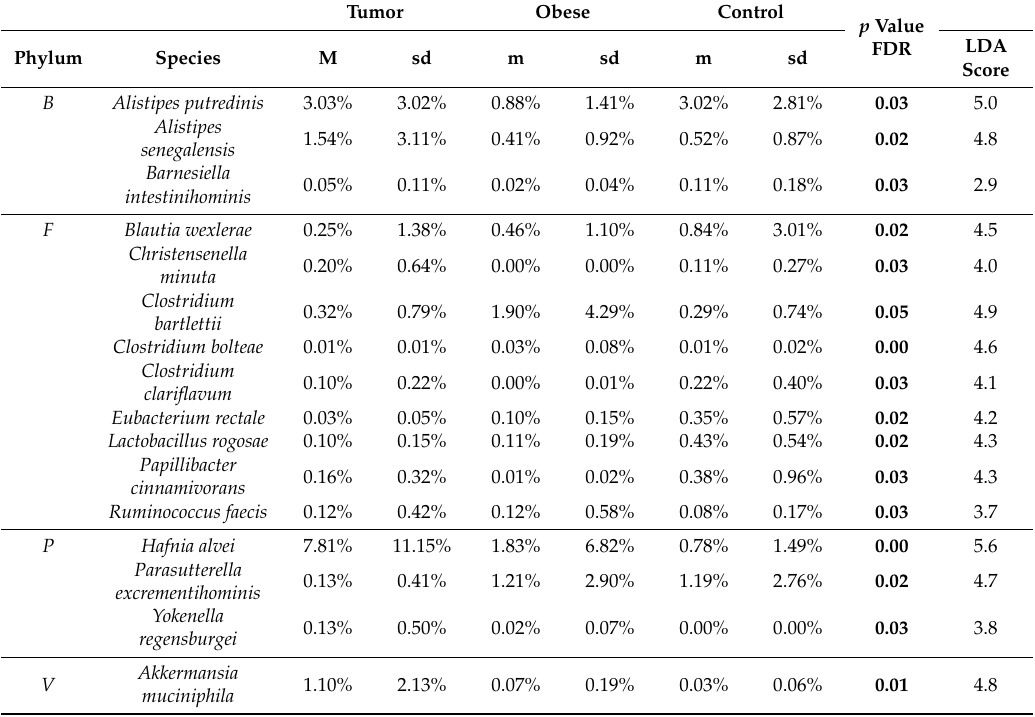
Table 4. Specific species. Linear discriminative analysis (LDA) e ff ect size (LEfSe) test showing the species associated with the three groups (Tumor, Obese, Control). Positive values of LDA scores (log 10) are indicative for enriched taxa in a given group. Significant p values are highlighted in bold.